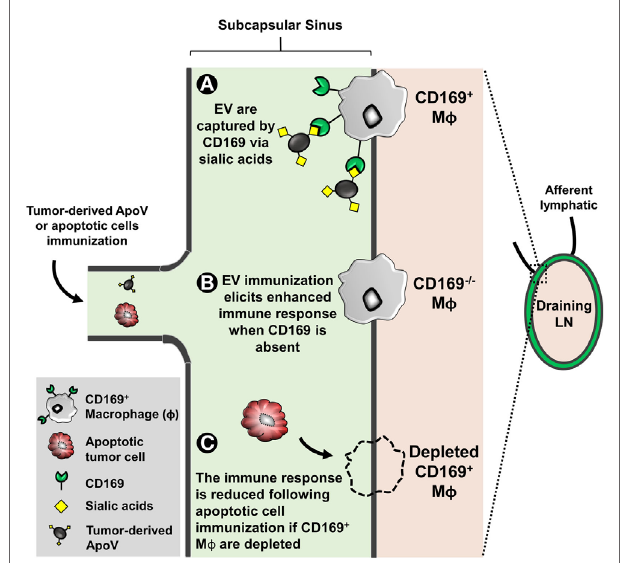
FiGURe 2 | The subcapsular sinus of lymph nodes (LN) is rich in macrophages expressing the surface molecule CD169. EVs are enriched in surface sialylated ligands. (A) CD169 + macrophages can bind to these EV in a sialic acid-dependent manner. CD169 binds to α 2,6 and α 2,3 sialic acids but prefers the latter (47, 49). (B) EL4 (thymoma)-derived apoptotic vesicle (ApoV) immunization, CD169 − / − mice elicit a significant enhanced cytotoxic response (47). The invasion of tumor cells from the primary site to the draining LN is unaffected by CD169 (217). However, the direct implication of EV and tumor metastasis with respect to CD169 remains unknown. (C) When depleted, CD169 + macrophages have a critical role in the anti-cancer effect (212). CD169 + macrophages cross-present tumor antigens from dead tumor cells to CD8 + T cells thereby mediating a cytotoxic- mediated anti-cancer immune